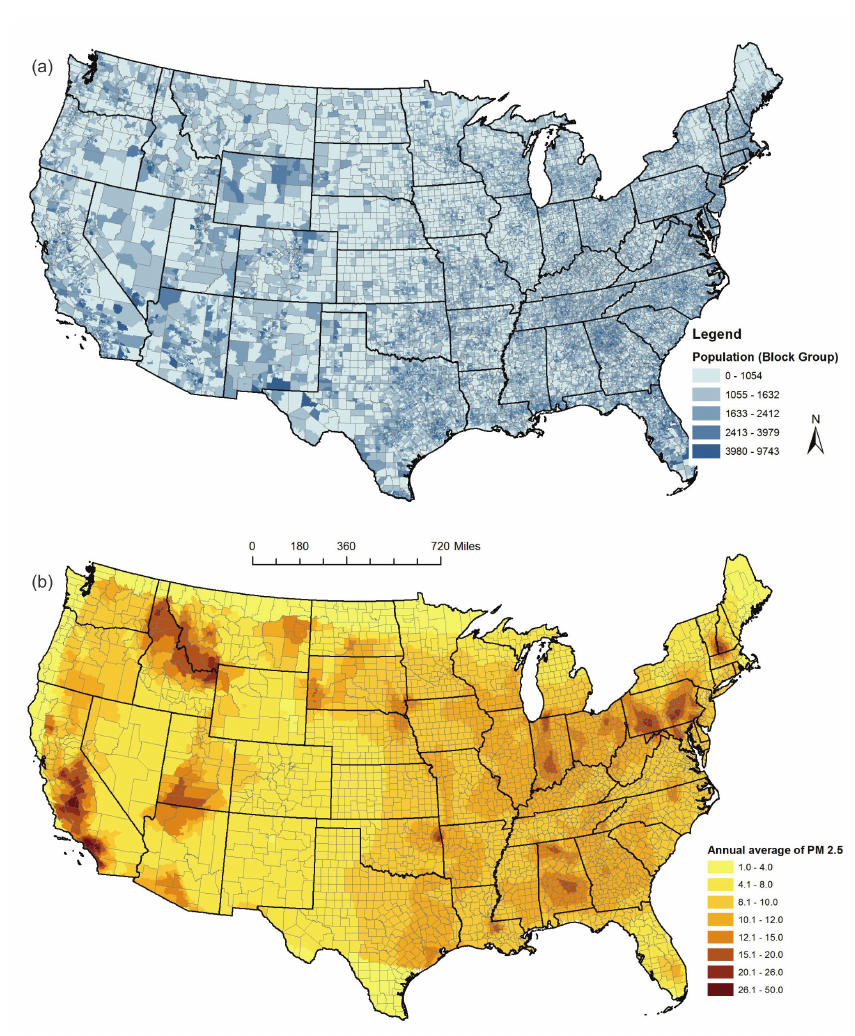
Figure 4. Spatial relationship between the PM 2.5 concentration and the population distribution across the contiguous United States in 2009. ( a ) population distribution; ( b ) annual average PM 2.5 . We used natural breaks to define the color ramps. A lighter color represents a smaller value, while a darker color represents a higher